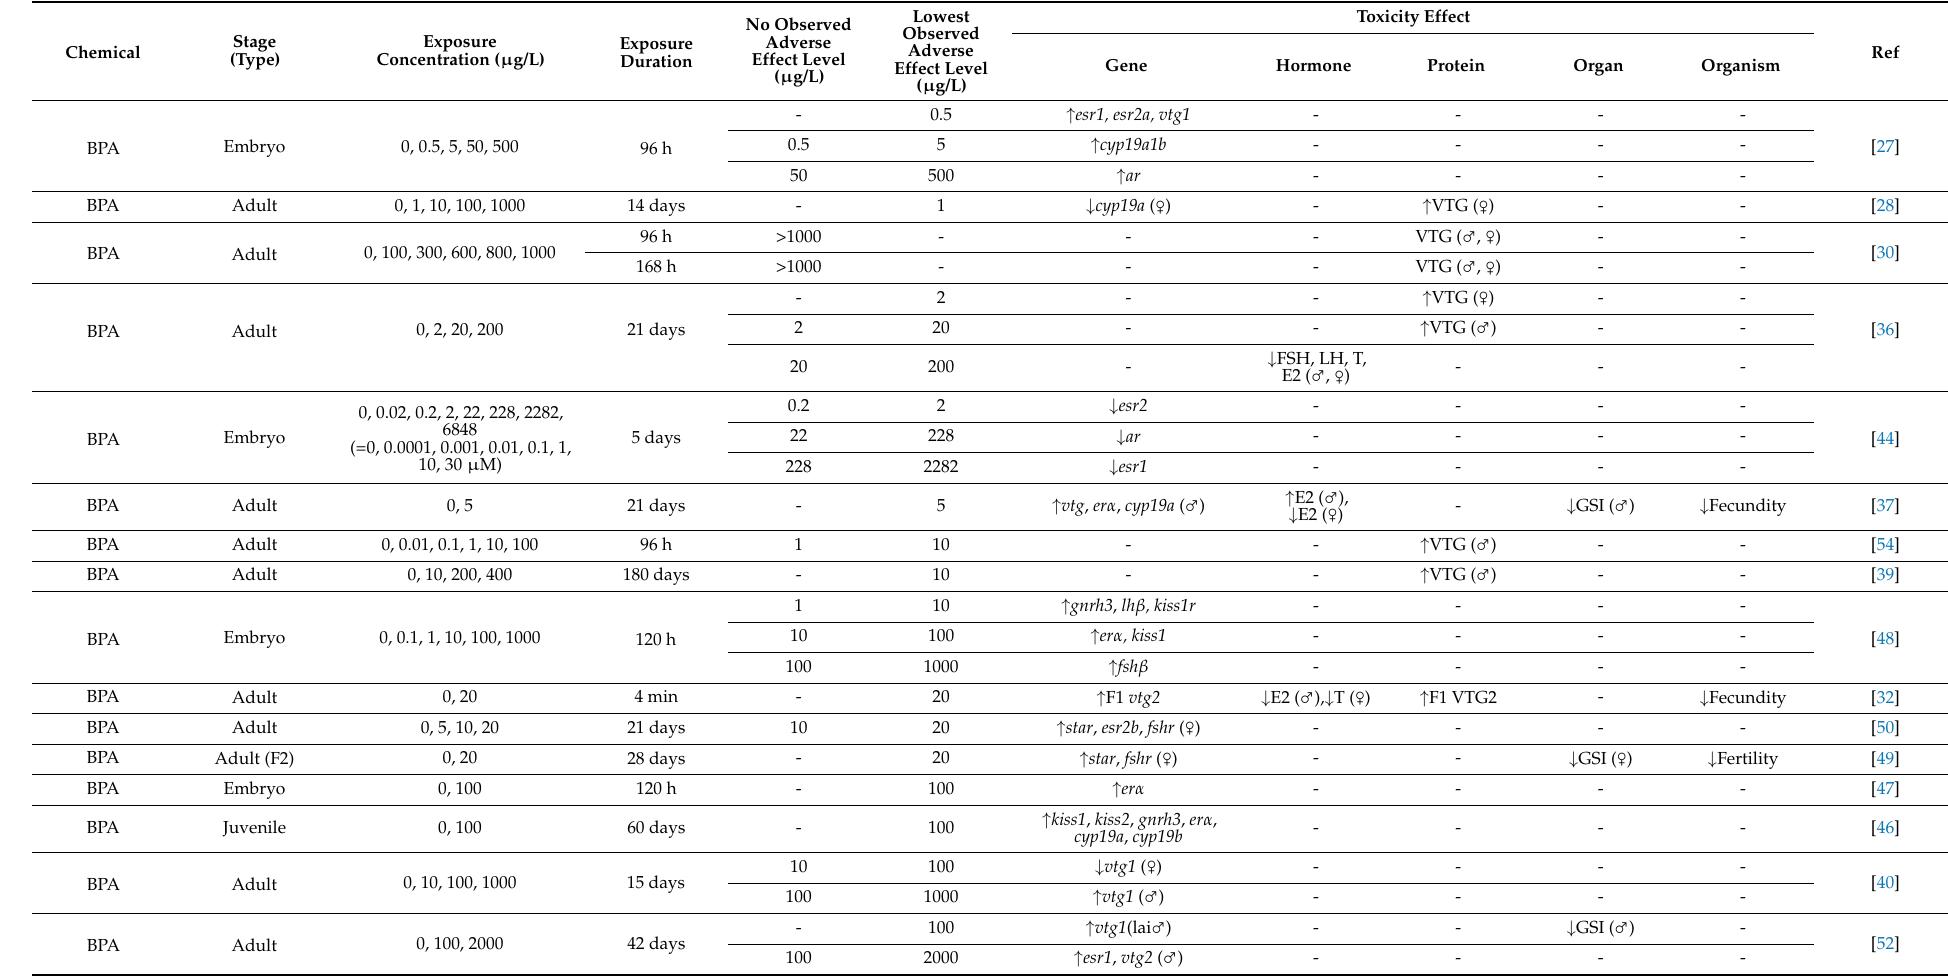
Table 3. Summary of studies about hypothalamic-pituitary-gonad (HPG) axis in zebrafish exposed to bisphenol A and its